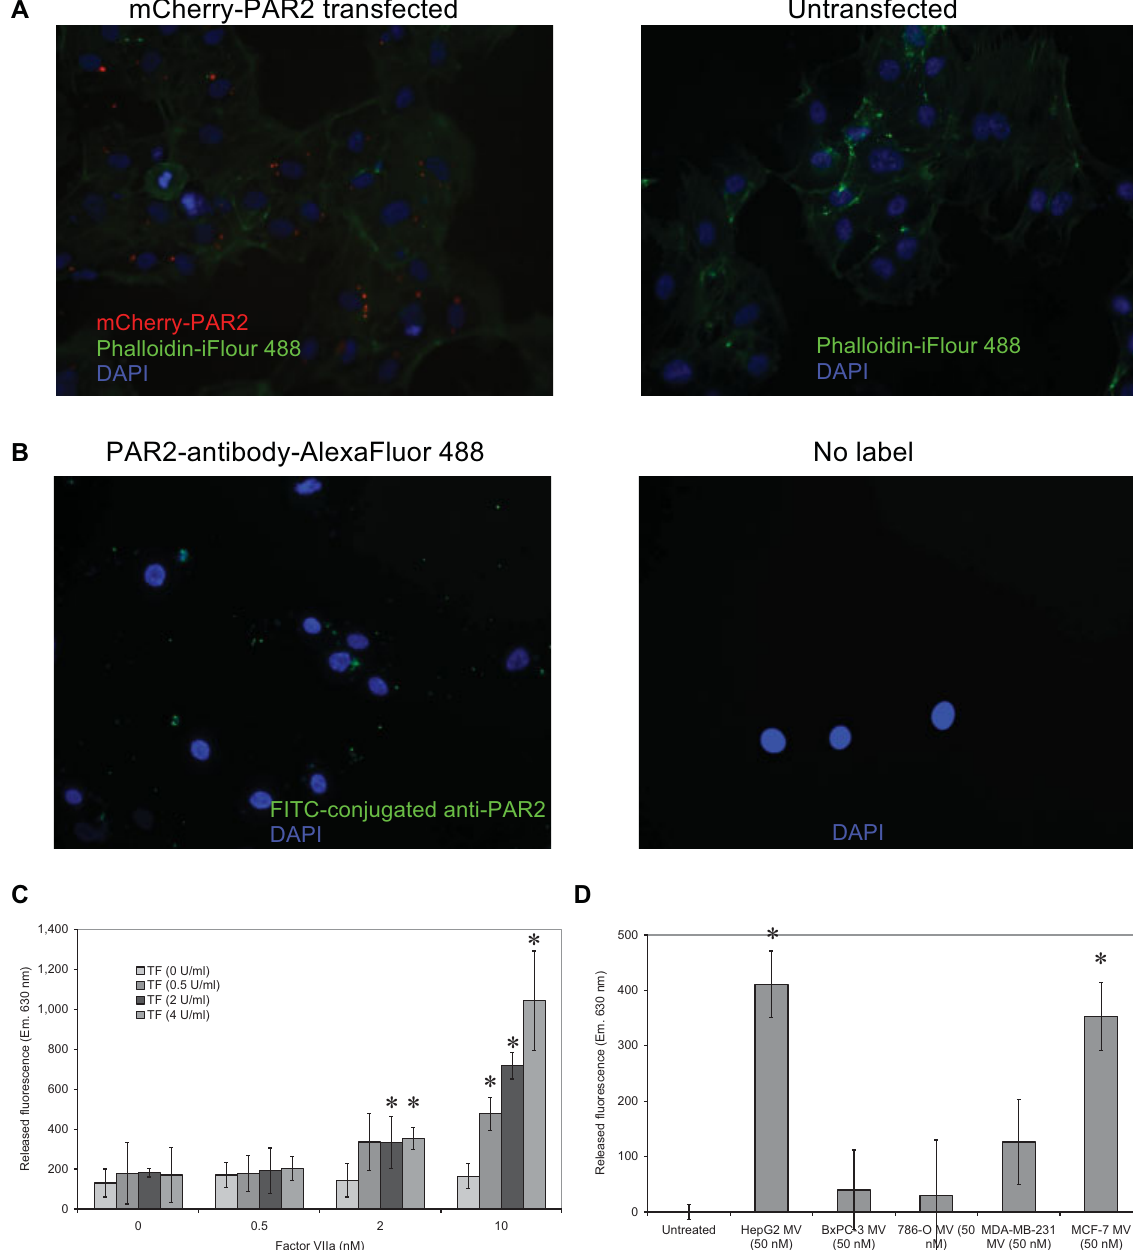
Fig. 5 Examination of the activation of PAR2 in response to fVIIa:TF complex and microvesicles. Sets of HCAEC (5 (cid:1) 10 3 ) were transfected to express mCherry-PAR2 hybrid protein. ( A ) Sets of transfected and untransfected cells were then fi xed and stained phalloidin-iFlour 488 (diluted 1:1000 v/v) and DAPI (2 µg/mL) and examined by fl uorescence microscopy for mCherry-PAR2 (Red), phalloidin-iFlour 488 (Green), and DAPI (Blue). ( B ) As a comparison, untransfected cells which were labeled with FITC-conjugated anti-PAR2 (SAM11; 20 µg/mL) or unlabeled cells. The cells were examined by fl uorescence microscopy for PAR2 (Green) and DAPI (Blue). ( C ) HCAECs expressing the mCherry-PAR2 protein were incubated for 1 hour withcombinations of TF (0 – 4 U/mL) together with fVIIa (0 – 10 nM) and the release of mCherry in the mediawas measured by determining the fl uorescence at Em. 630 nm (Ext. 580 nm) ( n ¼ 5; (cid:4) ¼ p < 0.05 vs. the untreated sample). ( D ) Sets of transfected cells were also incubated with microvesicles derived from the fi ve cell lines (HepG2, BxPC-3, 786-O, MDA-MB-231, and MCF-7) at 50 nM and the release of mCherry measured by determiningthe fl uorescenceat Em. 630 nm (Ext.580nm) ( n ¼ 5; (cid:4) ¼ p < 0.05 vs. the untreatedsample).HCAEC, human coronary artery endothelial cells; PAR2, protease-activated receptor-2; TF, tissue